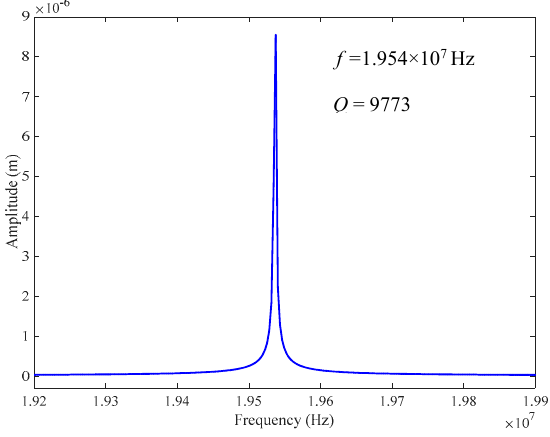
Figure 6. Amplitude–frequency response of the accelerometer at room temperature.